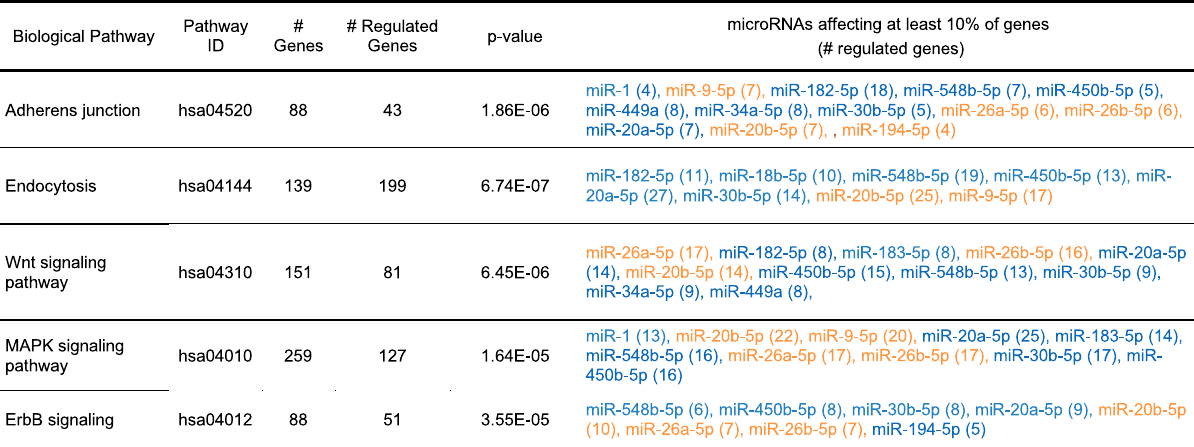
TABLE 2 | Top fi ve biological pathways, which could be affected by an overall change in microRNAs expression in patients chronically abusing alcohol. Analysis was performedusingDIANAmirPathandKEGGsoftwarewithFDRcorrectionand p valuethresholdof0.05.BluecolordepictsupregulatedmiRNA,orange — downregulated